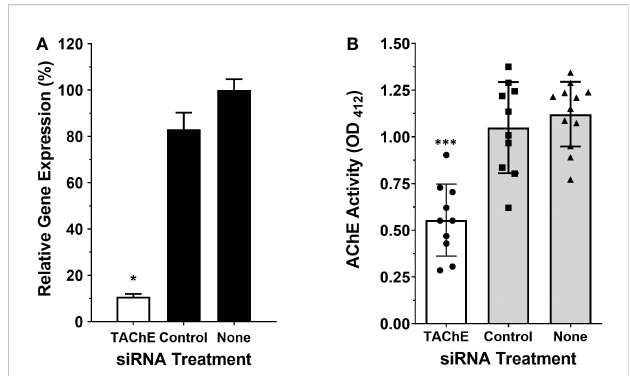
FIGURE 7 The SmTAChE gene encodes the surface AChE. Adult male parasites were treated either with an siRNA targeting SmTAChE, or with an irrelevant siRNA (Control) or with no siRNA (None), as indicated. (A) Treating parasites with siRNA targeting SmTAChE signi fi cantly suppressed the expression of this gene (by >90%; white bar, *p < 0.05 ANOVA) compared to controls, as revealed by RT-qPCR. (B) The AChE activity of all three groups of live parasites, one week after treatment, is shown, where each point represents the data from an individual parasite, and the bars indicates the mean for the group ( ± SD). Mean surface AChE activity is signi fi cantly lower in parasites treated with siRNA speci fi c for SmTAChE (white bar) compared to parasites treated with control siRNA or with no siRNA (None) (grey bars, ***p < 0.0001, ANOVA, n ≥